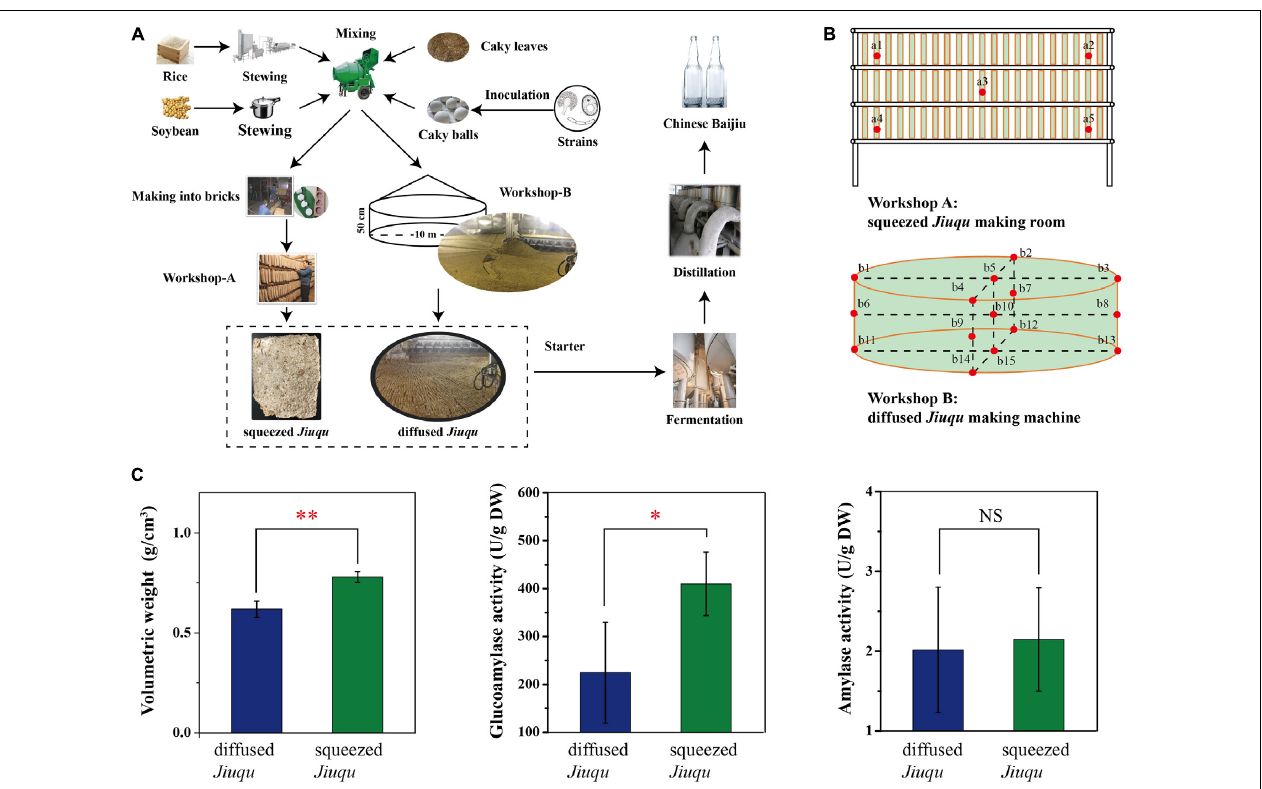
FIGURE 1 | Chinese Chixiang Aroma-Type (A) starter Jiuqu and Baijiu production and (B) samples collecting from squeezed Jiuqu making room and diffused Jiuqu making machine, (C) physicochemical and enzymatic activity profiles of diffused and squeezed Jiuqu (paired-sample t -test: NS, no significant; ∗ , p < 0.05; ∗∗ , p < 0.01; ∗∗∗ , p <